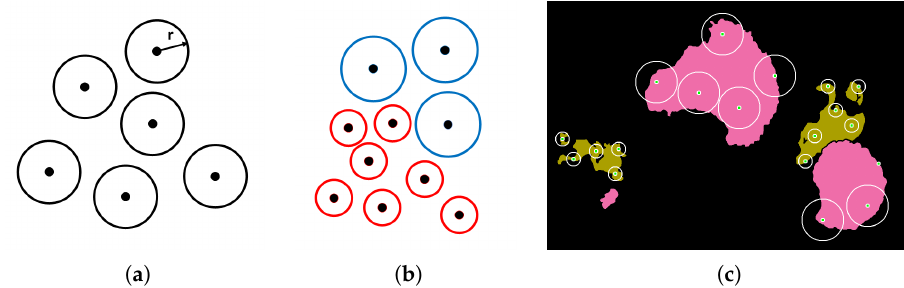
Figure 2. Ortho sampling strategy. ( a ) The Poisson-disk sampling generates random samples such that a disk of radius r , centered on each sample, never overlaps with other disks. ( b ) The radius changes such that a minority class (red) receives more samples than a majority one (blue). An example is shown in ( c ): the radius of the Pocillopora (pink) and encrusting Montipora (olive) classes are respectively 30 and 60